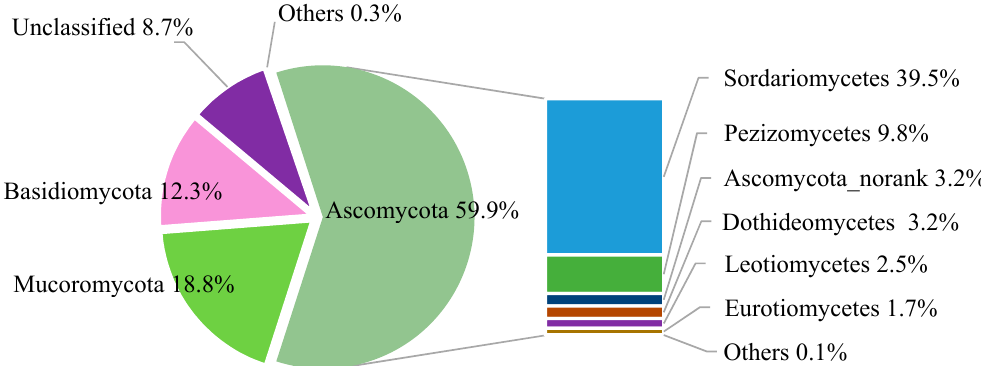
Figure 1. The bar of the pie plot showing the relative abundance of soil fungal phyla (left) and Ascomycota classes (right) with different treatments. The four dominant phyla were Ascomycota (59.9%), Mucoromycota (18.8%), Basidiomycota (12.3%), and Unclassified (8.7%), respectively. The primary fungi ( Ascomycota ) mainly consisted of Sordariomycetes , Pezizomycetes , Dothideomycetes , Leotiomycetes , and Eurotiomycetes .